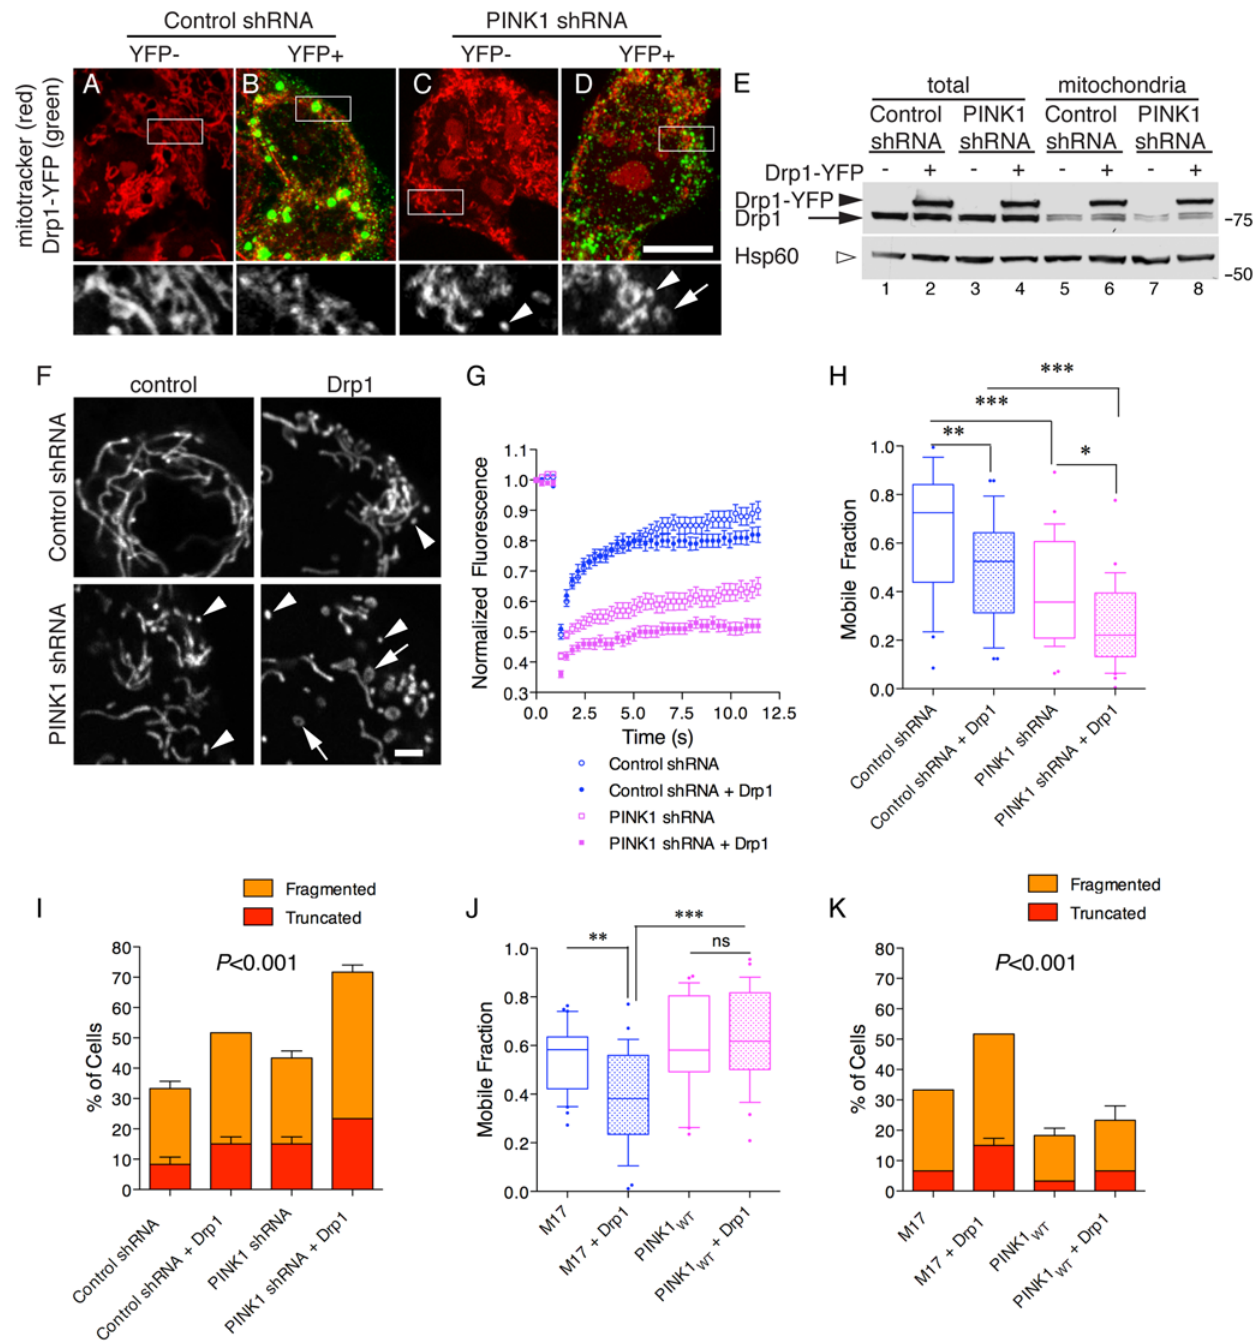
Figure 6. PINK1 deficiency and increased Drp1 expression have additive effects. (A–D) Control shRNA (A,B) or PINK1 shRNA (C,D) were transfected with YFP-Drp1 (green in upper panels) and stained with mitotracker (red in upper panels; lower panels show an enlarged portion of the mitotracker channel only). At 24 hours after transfection, PINK1 shRNA lines (D) showed more mitochondrial damage than control shRNA lines. Arrowheads showsmall fragments of mitochondriathat areparticularly seen in PINK1deficient cells,arrowsshow circular fragments that areonly seen in PINK1 deficient cells. Scale bar in the lower panel of (D) is 10 m m and applies to all photomicrographs. (E) Control shRNA and PINK1 shRNA cells were transfected with YFP or YFP-Drp1. Total cell lysates or mitochondrial fractions were blotted for Drp1 or Hsp60 as a loading control. Markers on the right arein kilodaltons. (F)Control shRNA (upper panels) or PINK1shRNA cells (lower panels) were transfectedwith mito-YFP without (left panels) or with Drp1 (right panels) and live images taken. As in A–D, arrowheads show small fragments and arrows circular remnants of mitochondria. Scale bar in the lower right panel is 2 m m, applies to all fluorescence micrographs. (G, H) FRAP was used to assess the effect of Drp1 overexpression as in figure 3. Open symbols are untransfected cells, closed symbols were transfected with Drp1 for 24 hours. The FRAP curves over time in (G) are the average of 30 observations, representative of duplicate experiments. Error bars indicate the SEM. (H) Summary data for the mobile fractions are shown from n =30 cells, representative of duplicate experiments. Differences between treatments were significant overall ( P , 0.0001 by ANOVA) and Student-Newman Kuells’ post-hoc test was used to compare each line with and without Drp1 expression. * P , 0.05; ** P , 0.01; *** P , 0.001. (I) Counts of mitochondrial morphology as in figure 2 were performed on 60 cells from duplicate experiments in control shRNA or PINK1 shRNA cell lines. Differences were analyzed